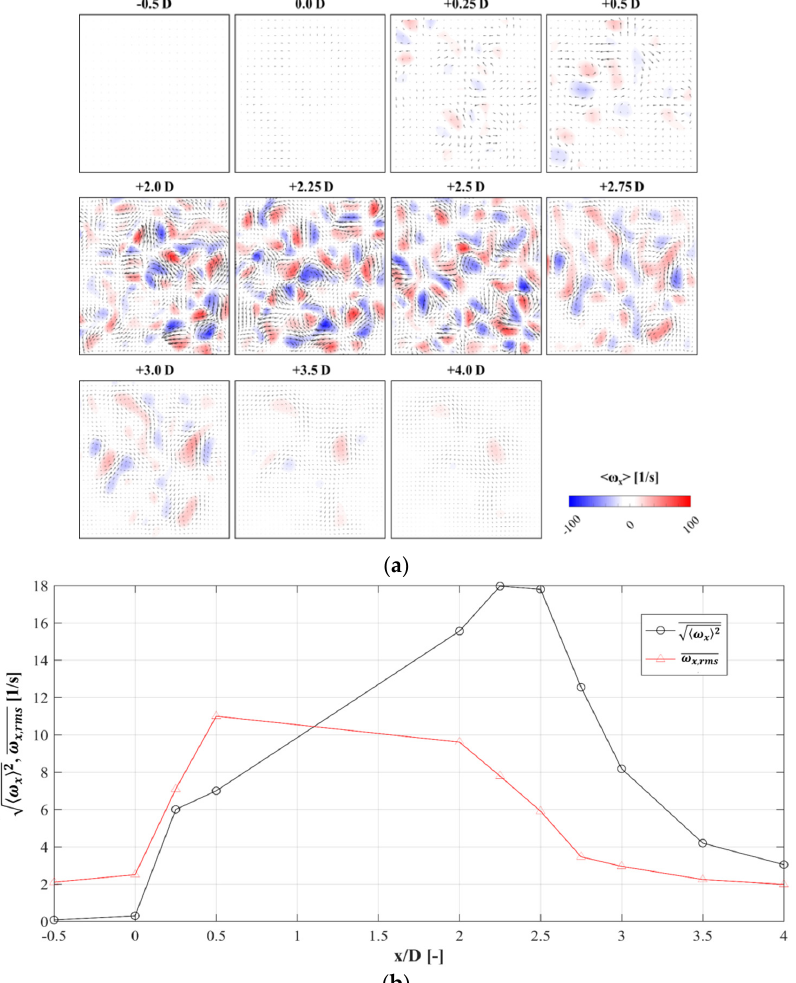
Figure 12. Evolution of span-wise vorticity: ( a ) span-wise vorticity at the positions, and ( b ) spatially-averaged vorticity magnitude—RMS fluctuation values.